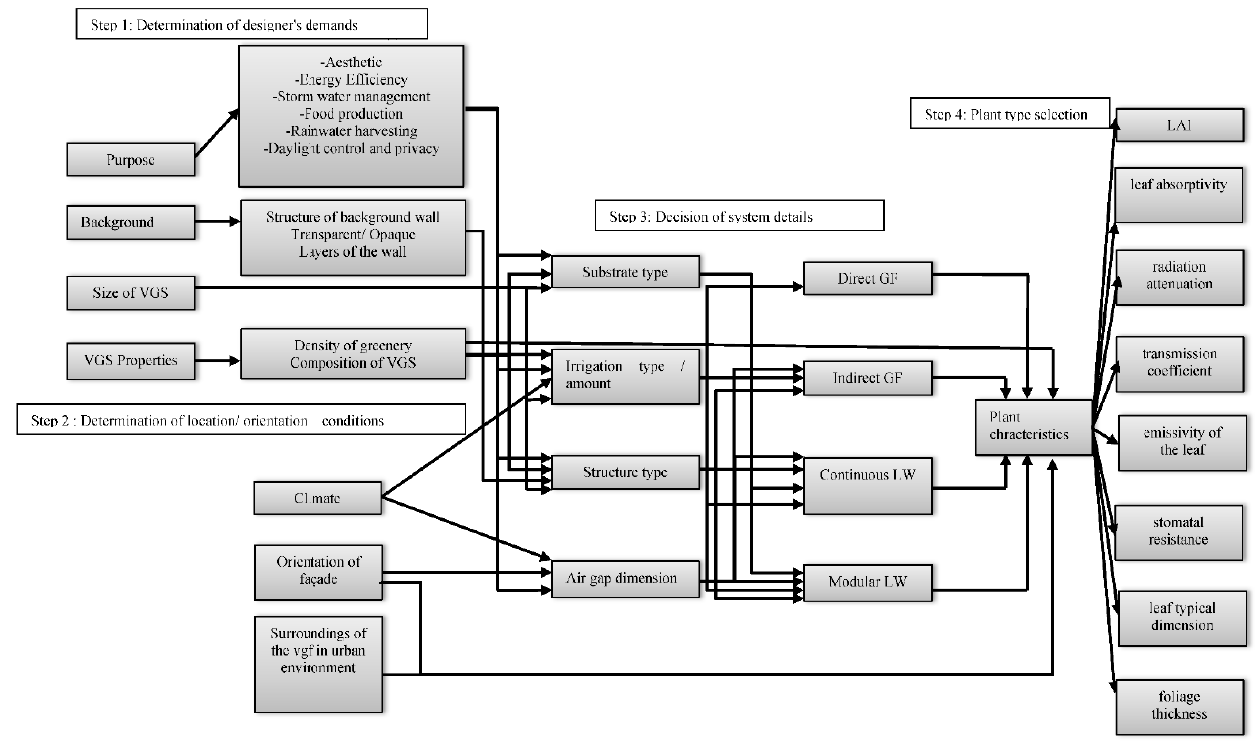
Figure 5. Design support model for energy-efficient vertical green systems